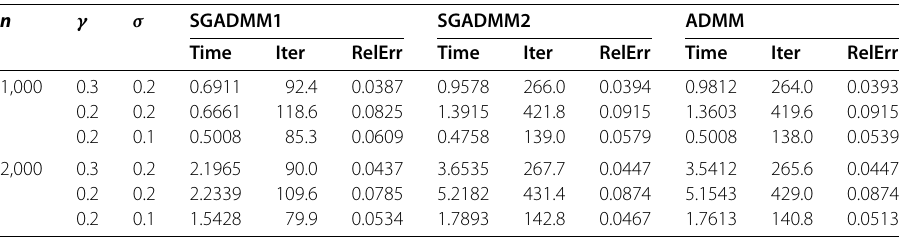
Table 1 Comparison of SGADMM1, SGADMM2 and ADMM n